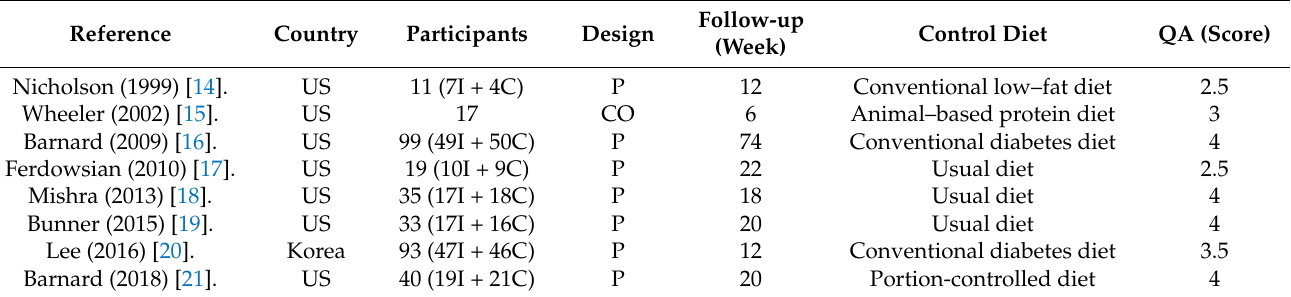
Table 2. Characteristics of randomized controlled